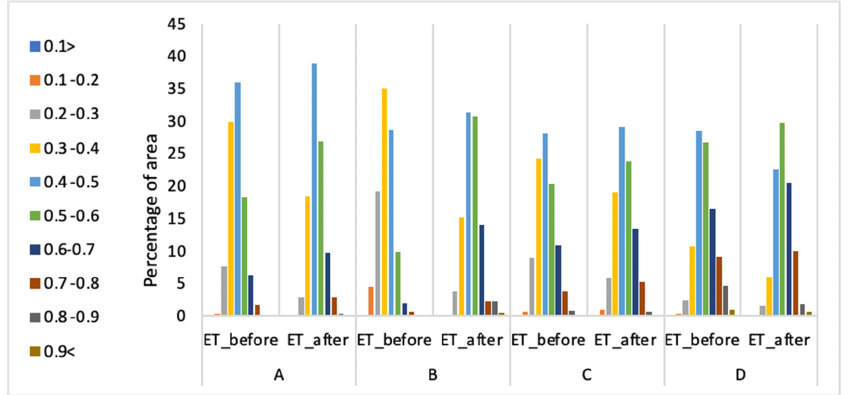
Figure 9. Percentage area of different pistachio tree evapotranspiration classes (mm/day) before and after foliar application of gypsum (plot ( A )) and of gypsum again, gypsum, NAX-95 (calcium-based suspension coating), and sulfur in plots ( A ), ( B ), ( C ), and ( D ), respectively.